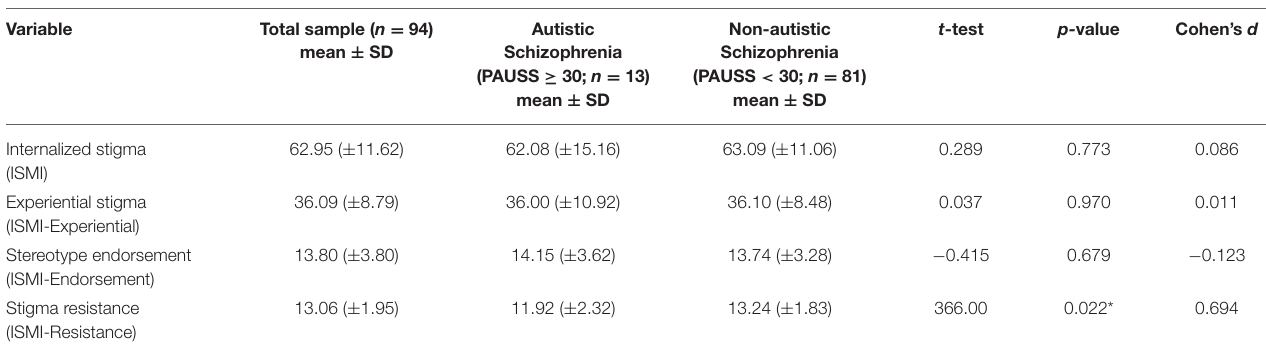
TABLE 3 | Between-group comparison for internalized stigma.